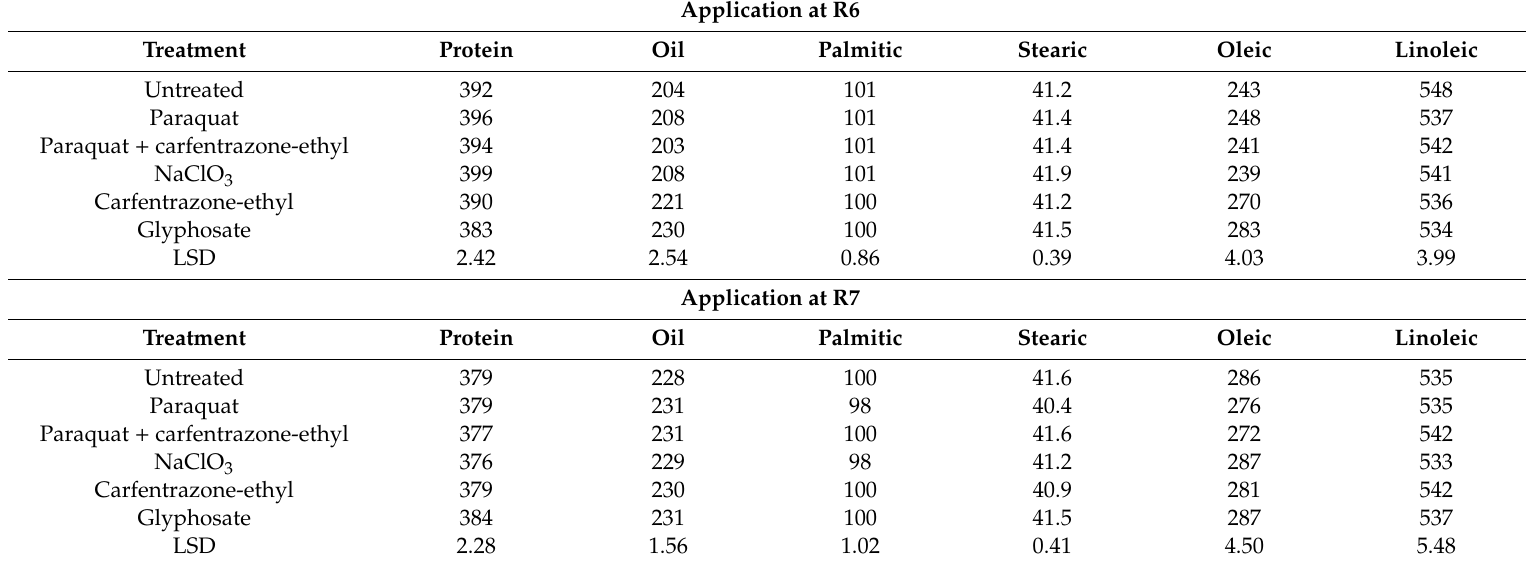
Table 3. E ff ects a of harvest aids (treatments: paraquat, paraquat + carfentrazone-ethyl, carfentrazone-ethyl, NaClO 3 , glyphosate) on seed protein, oil, and fatty acids (g kg − 1 ) across two years. Untreated plants were used as the control. Harvest aids were applied at growth stages R6 and R7. The experiment was conducted in 2012 and 2013 in Stoneville,